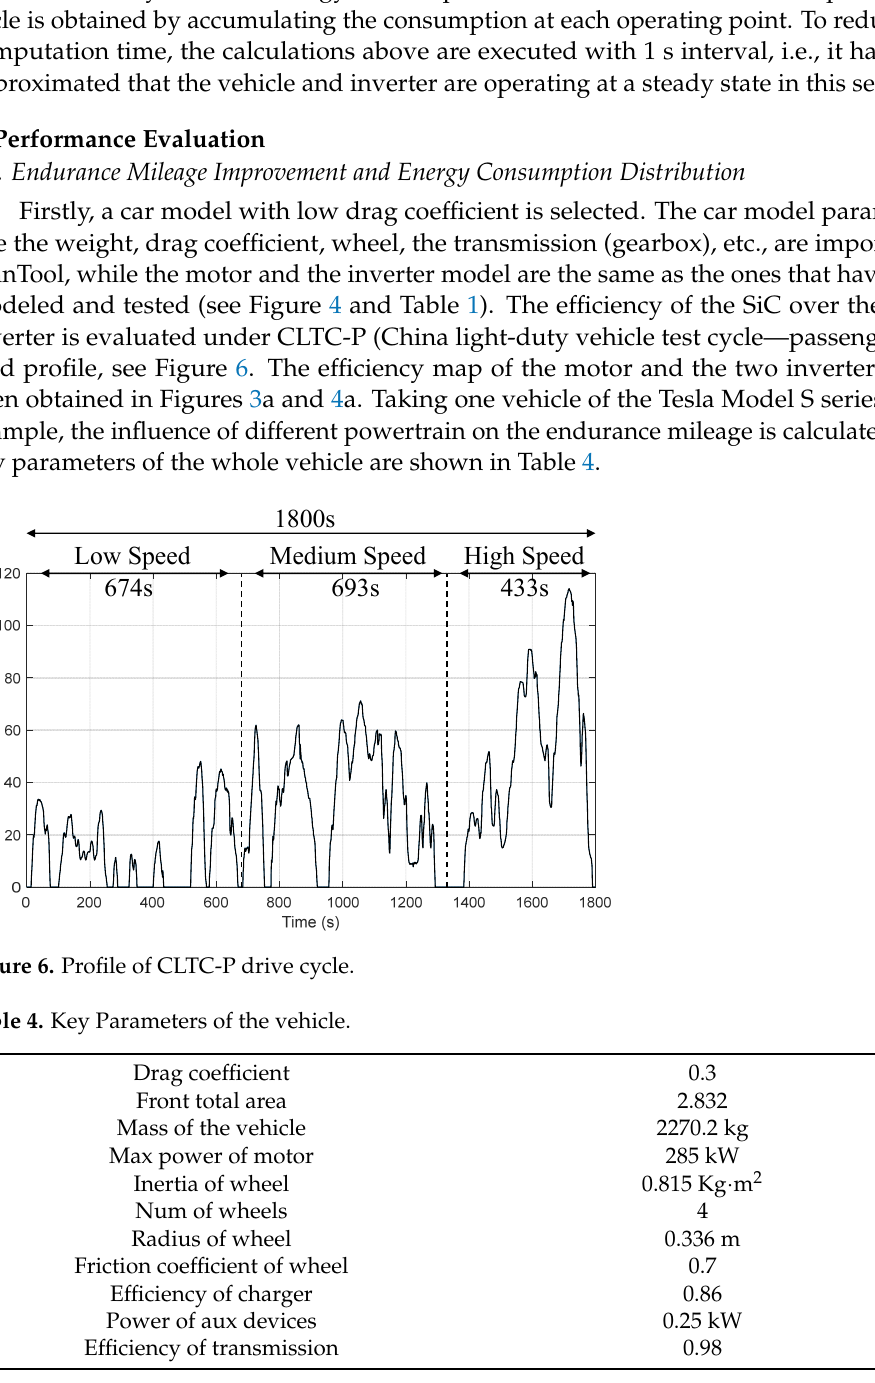
Figure 5. Calculation flow of the vehicle-level modeling.